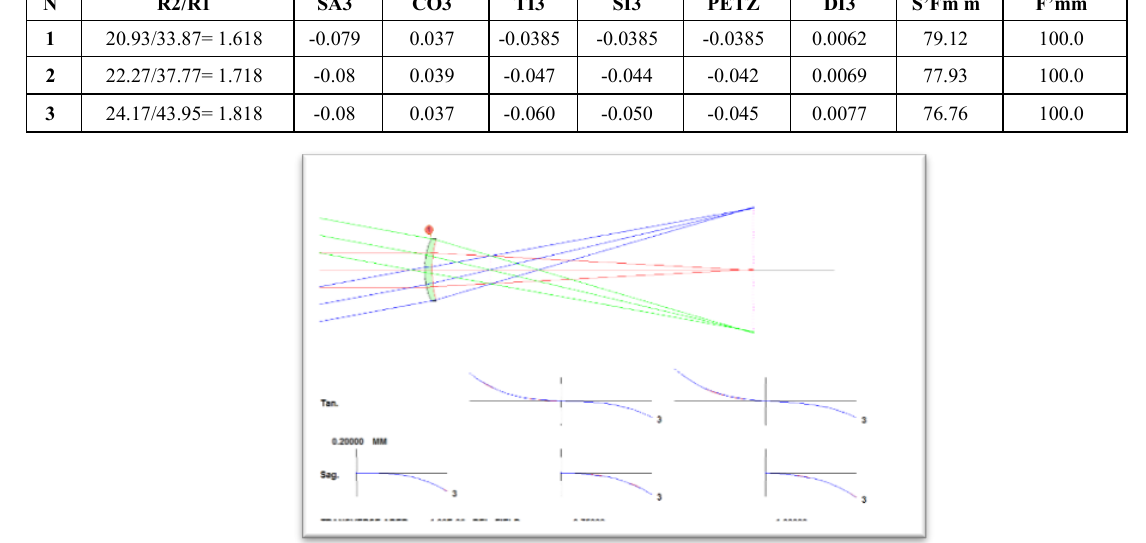
Fig. 1. Optical scheme of meniscus under goldenratio and plots of its transverse